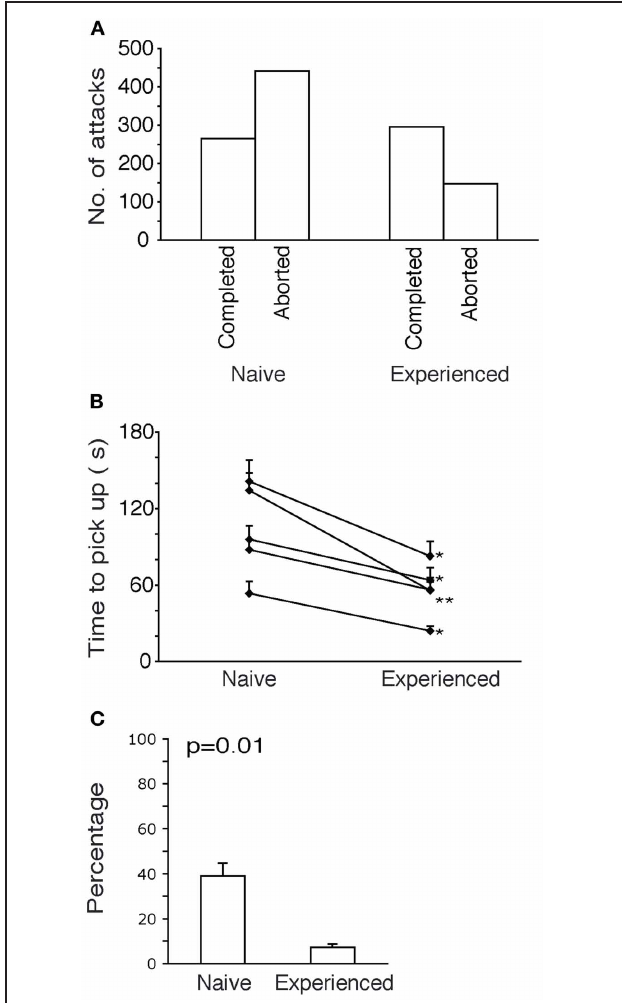
FIGURE 6 | Further characteristics of attacks on novel and familiar prey. (A) Comparison of success rate between Naïve and experienced animals. Naïve animals had 62% attacks aborted but after experience only 33% attacks aborted. (B) Attack durations. After experience all animals show a significant reduction in time taken to pick a roach (paired t -tests, two-tailed, p < 0 . 05). (C) Paw use. Naïve animals used the fore paw in 40% of the attacks. Experienced animals used the fore paw in only 7% of the